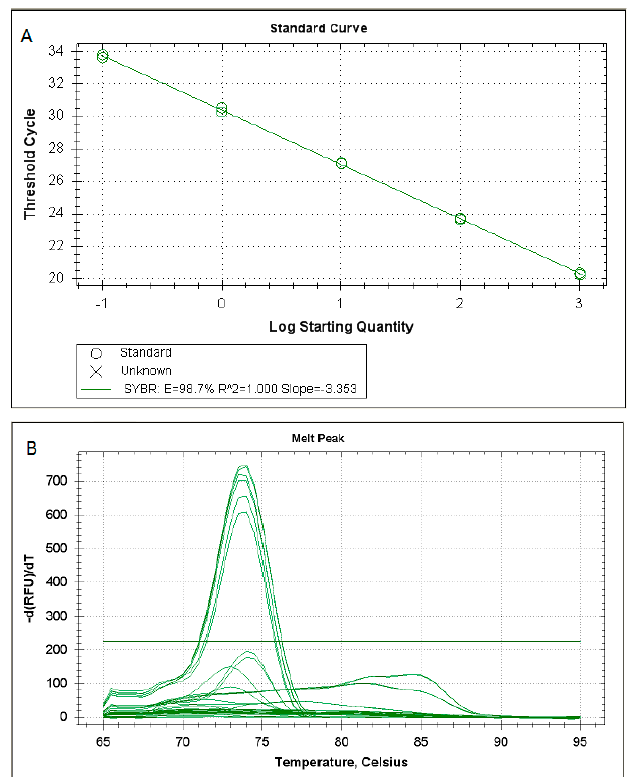
Figure 1. Customary values obtained for the standard curve ( A ) and melting temperature analysis ( B ) of the SYBR Green RT-PCR for Rickettsia spp. based on the amplification of an ompB fragment. The reaction resulted to be positive for all the analyzed Rickettsia species (Figure 2A).